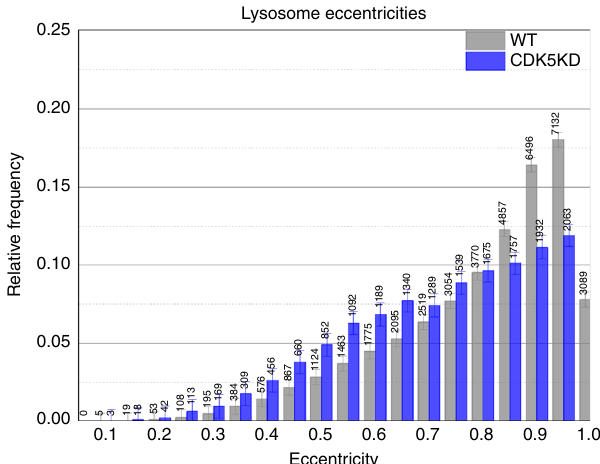
Fig. 8 Lysosome deformation is reduced in CDK5 knockdown background. Histogram of lysosome eccentricities in control cells (gray) and CDK5 knockdown cells (blue). Eccentricity of 0 is a perfect circle, and eccentricity of 1 re fl ects highly elongated lysosomes; note the increased frequency of large eccentricities (gray bars at 0.9, 0.95, 1) in the control relative to the CDK5 knockdown. Distributions were determined to be very different (KS test, P < 0.0001) Quanti fi ed data represent n = 2 independent